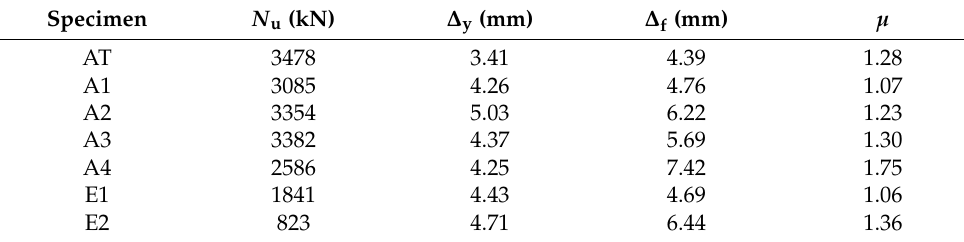
where Δ f is the limit displacement, and Δ y indicates the nominal yield displacement.